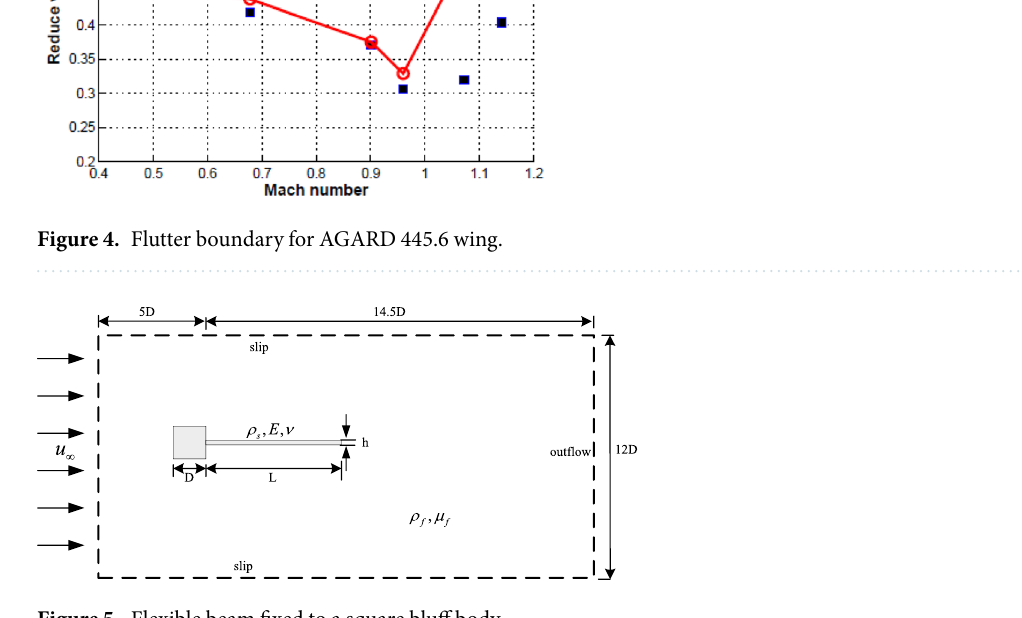
Figure 5. Flexible beam fixed to a square bluff